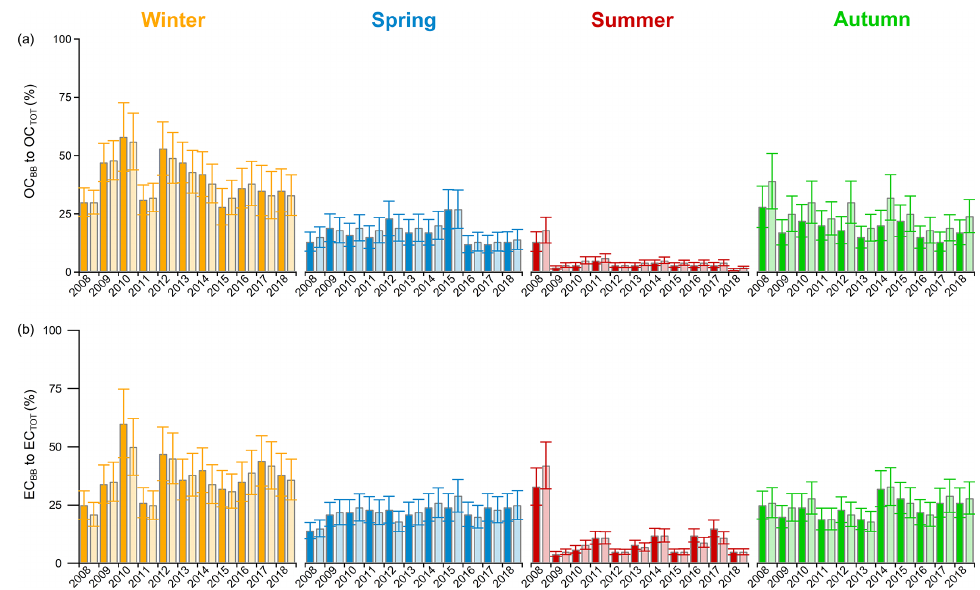
Figure 9. Relative contribution of OC BB to OC TOT (a) and EC BB to EC TOT (b) in PM 10 (dark colours) and in PM 2 . 5 (light colours), as a function of season at Birkenes for the 2008–2018 period (DJF represents winter, MAM represents spring, JJA represents summer, and SON represents